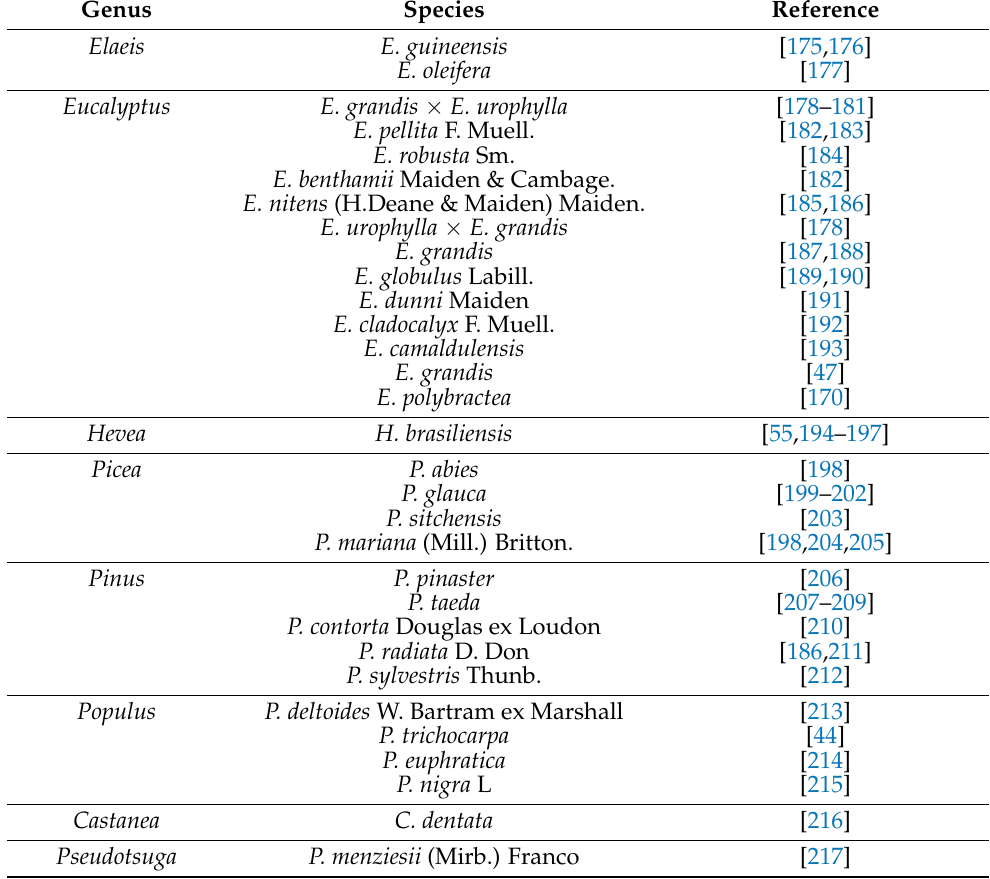
Table 1. Application of GS in woody